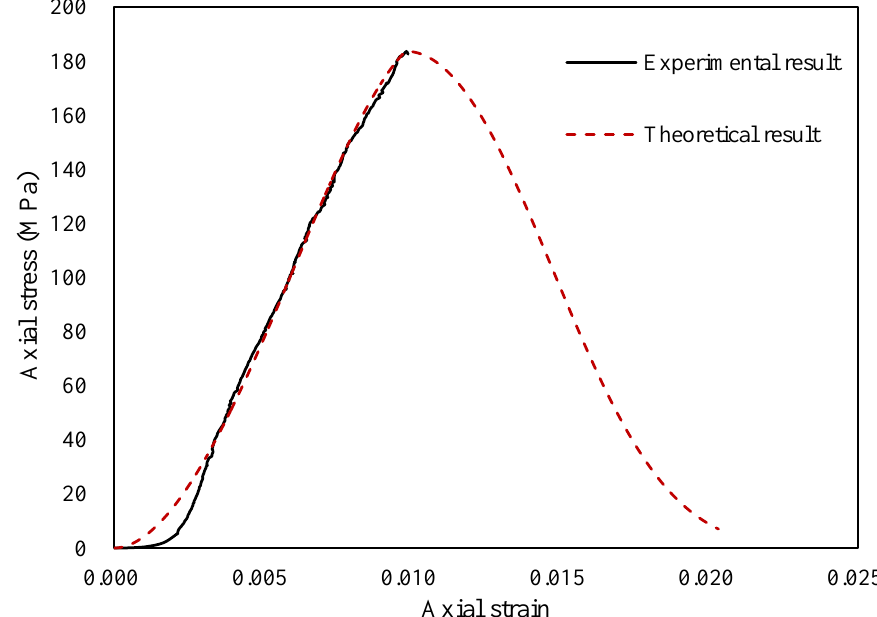
Figure 4. The verification of the TM damage evolution model for an untreated granite specimen.